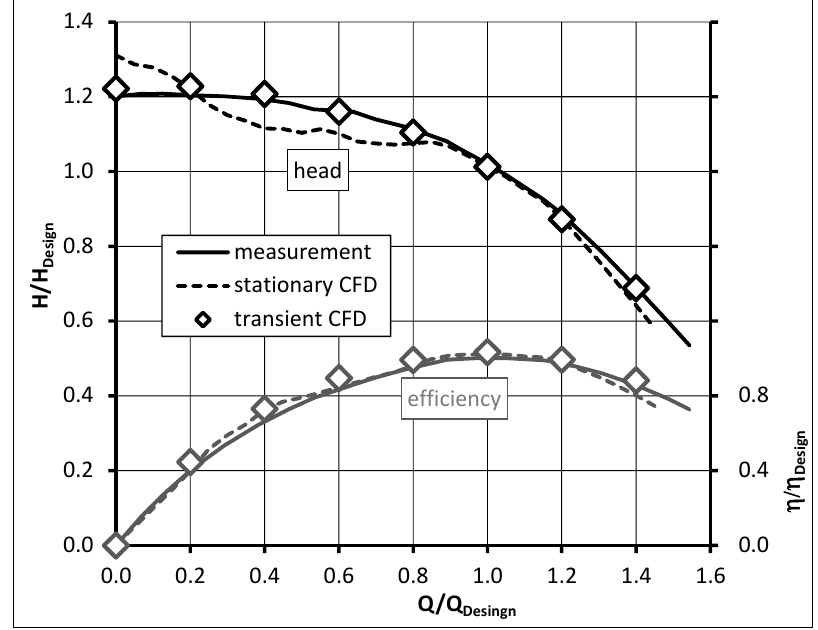
Figure 9. Numerical (dashed) and test rig results (solid) for head and efficiency—low n q pump.